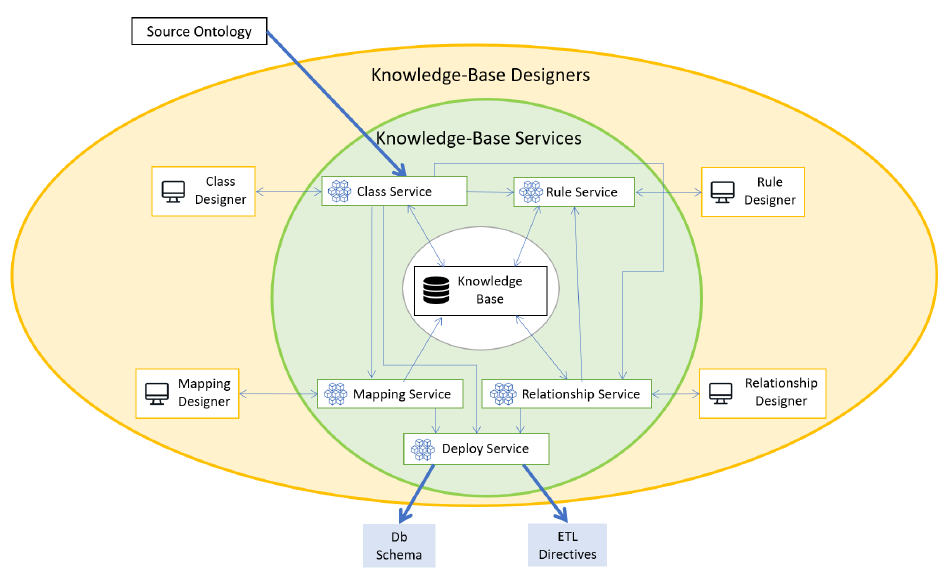
Figure 10. Architecture of the Knowledge-Base Manager